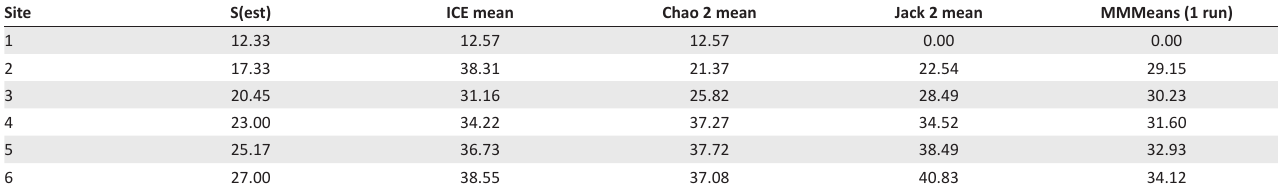
TABLE 2-A4: Richness estimator values as obtained from Estimate-S (v 9.1.0; Colwell 2013). Site